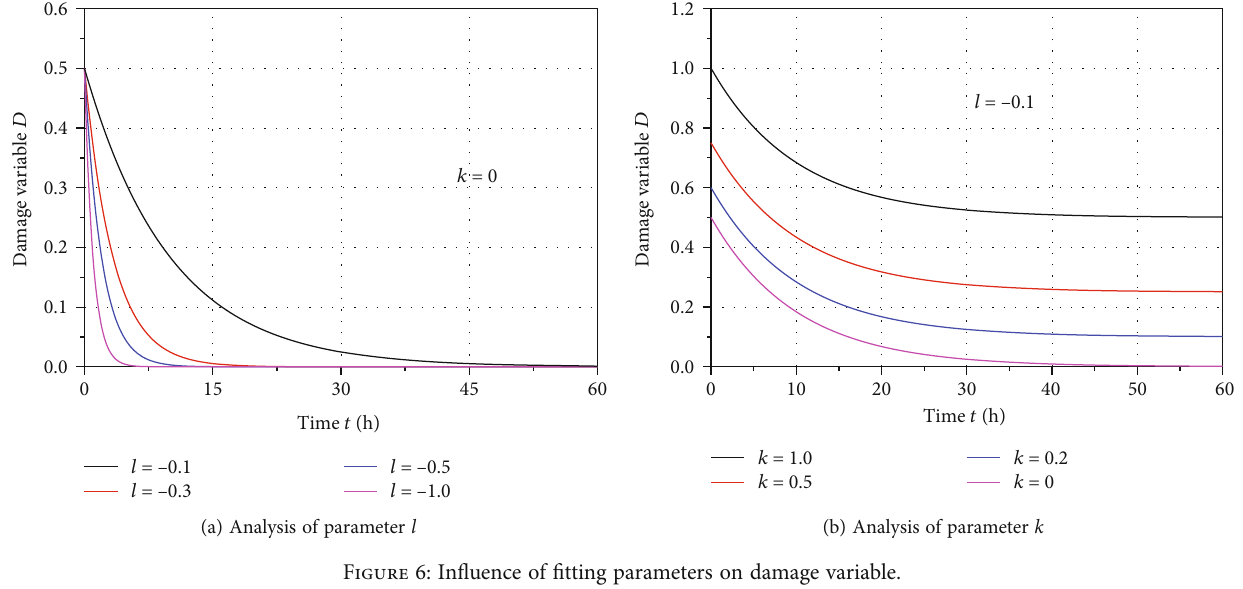
Figure 6: In fl uence of fi tting parameters on damage variable.